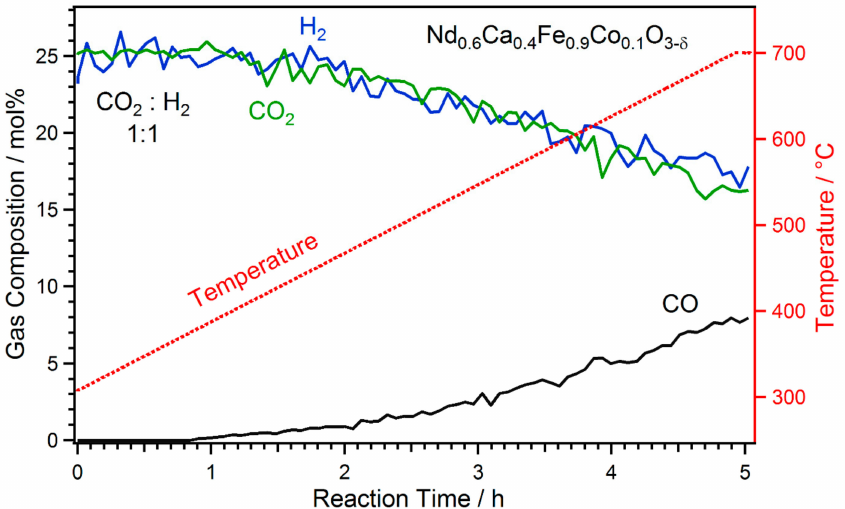
Figure 1. rWGS reaction with a CO 2 to H 2 ratio of 1:1 on Nd 0.6 Ca 0.4 Fe 0.9 Co 0.1 O 3- δ . A temperature ramp between 300 ◦ C and 700 ◦ C with a linear increase of 80 ◦ C h − 1 was carried out. CO formation started around 375 ◦ C. With increasing temperature, CO formation increased to a maximum of ~8 mol% at 700 ◦ C. This experiment was performed with a reduced amount of catalyst (~5 mg) to stay below the thermodynamic